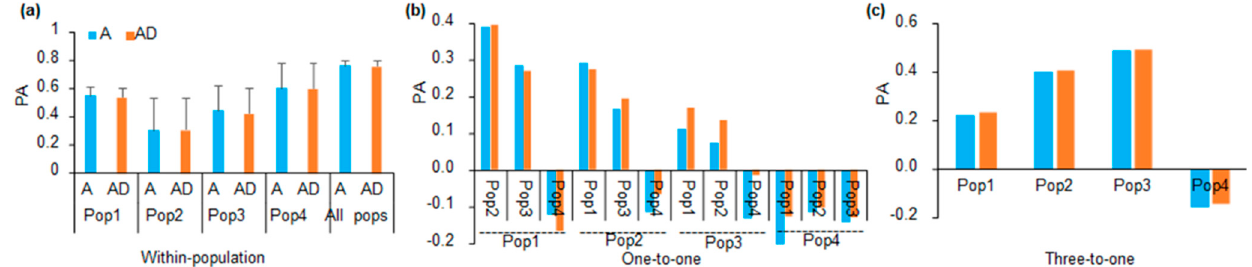
Figure 2. GP across different populations. ( a ) PA of the within-population GP, which was performed with five-fold CV and was repeated 100 times. A and AD were the GBLUP models including only additive effect, and additive plus dominance effects, respectively; Pop1-Pop4 were population 1-4, and all pops indicated all populations were used together to perform within-population GP ( b ) PA of the one-to-one prediction scheme. The lower name in the x-axis is the training population, and the upper name in the x-axis is the validation population; ( c ) PA of the three-to-one prediction scheme. The populations in the x-axis are the validation population, and the remaining three populations were used together as the training population.